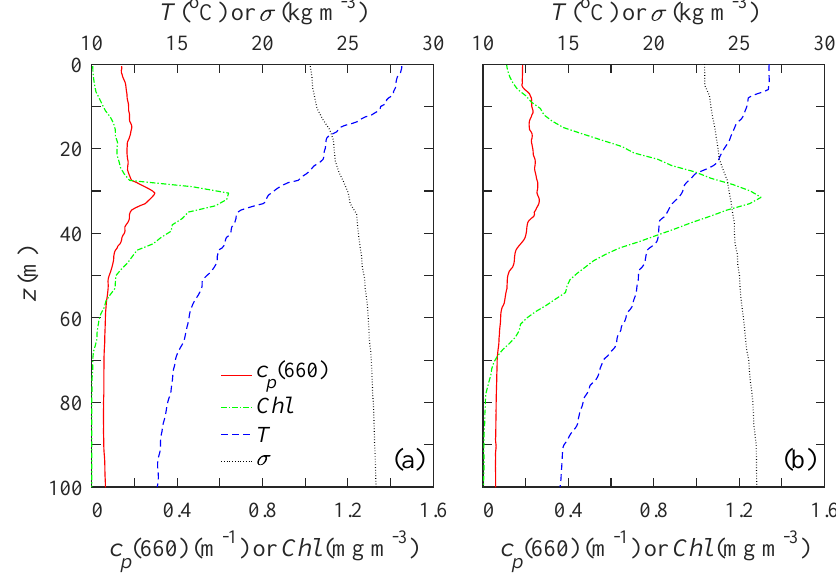
Figure 2. Vertical profiles of water temperature T , density anomaly σ , chlorophyll- a concentration Chl , and beam attenuation coefficient of particles at 660 nm c p (660) measured at two contrasting stations. ( a ) Station in the Guaymas Basin (27.54 ◦ N, 111.64 ◦ W) with lower Chl and c p and smaller solar zenith angle of ~5 ◦ and ( b ) station in the Farallon Basin (25.28 ◦ N, 109.58 ◦ W) with higher Chl and c p and larger solar zenith angle of ~57 ◦